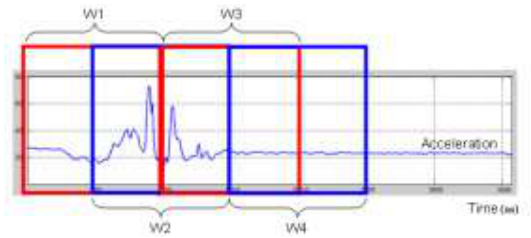
Fig. 7. Sliding window